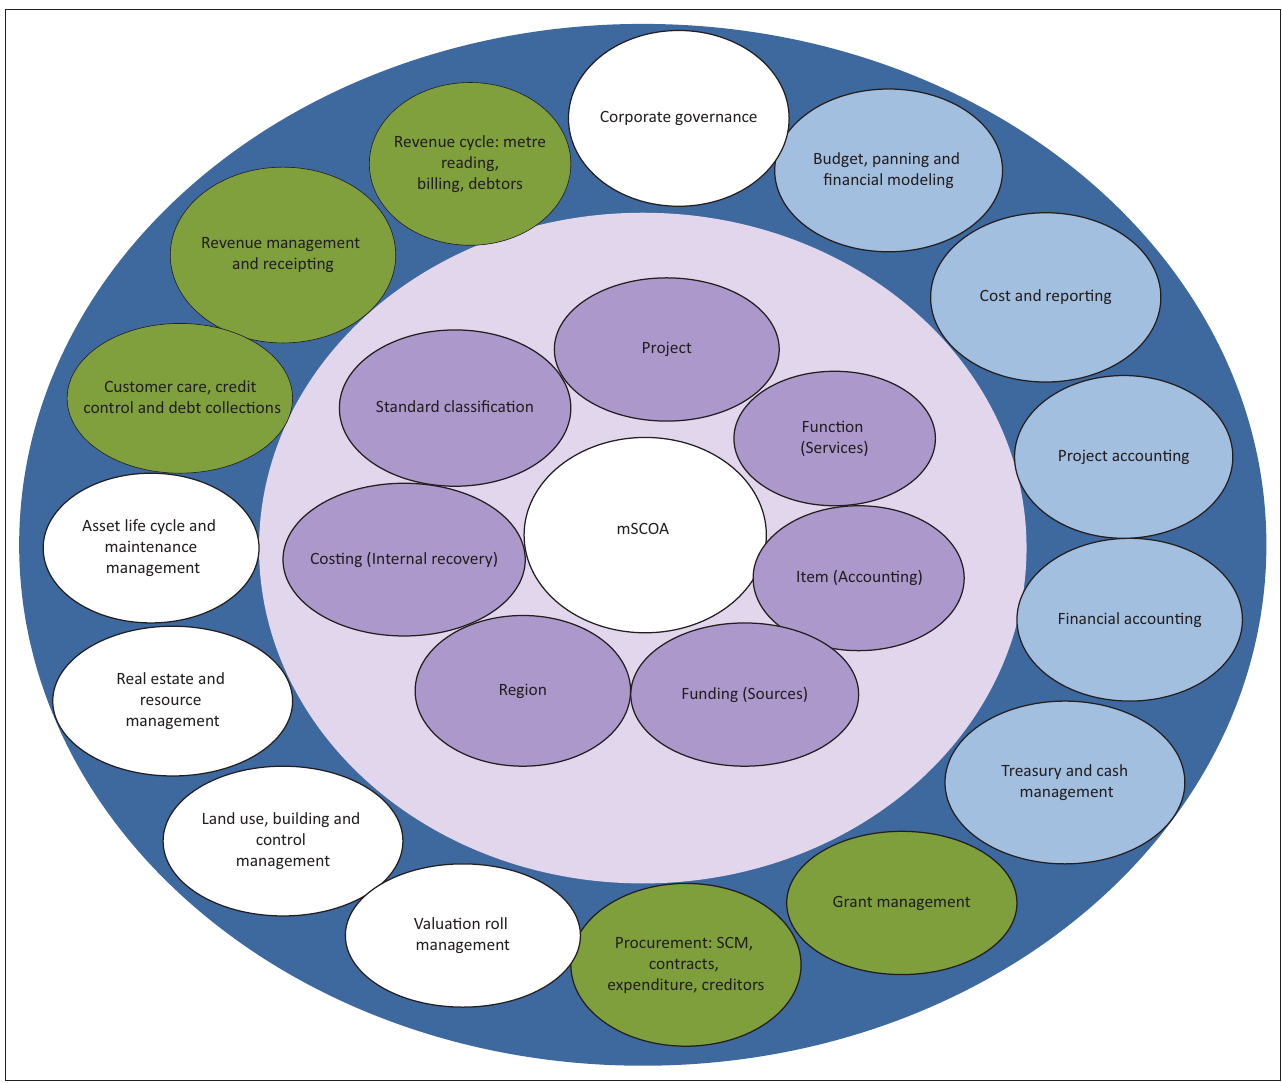
FIGURE 1: The Municipal Regulations on a Standard Chart of Accounts chart for local government